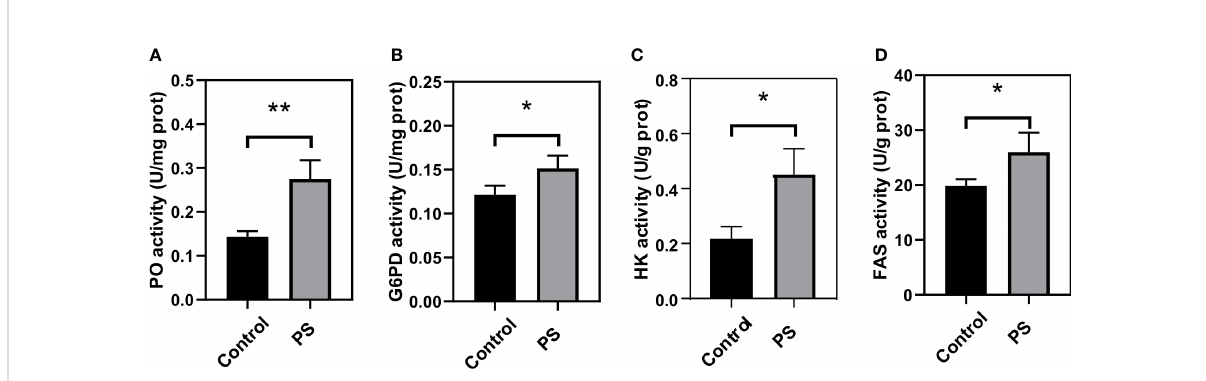
FIGURE 7 Changes of key enzymes involved in immunity and energy metabolism in the fat body of Bombyx mori larvae at 24 h after injecting with Poria cocos polysaccharides (PS). (A) phenoloxidase, (B) glucose-6-phosphate dehydrogenase, (C) hexokinase, and (D) fatty acid synthetase activities. The data was presented as mean ± SD for three independent experiments (* P < 0.05, ** P <